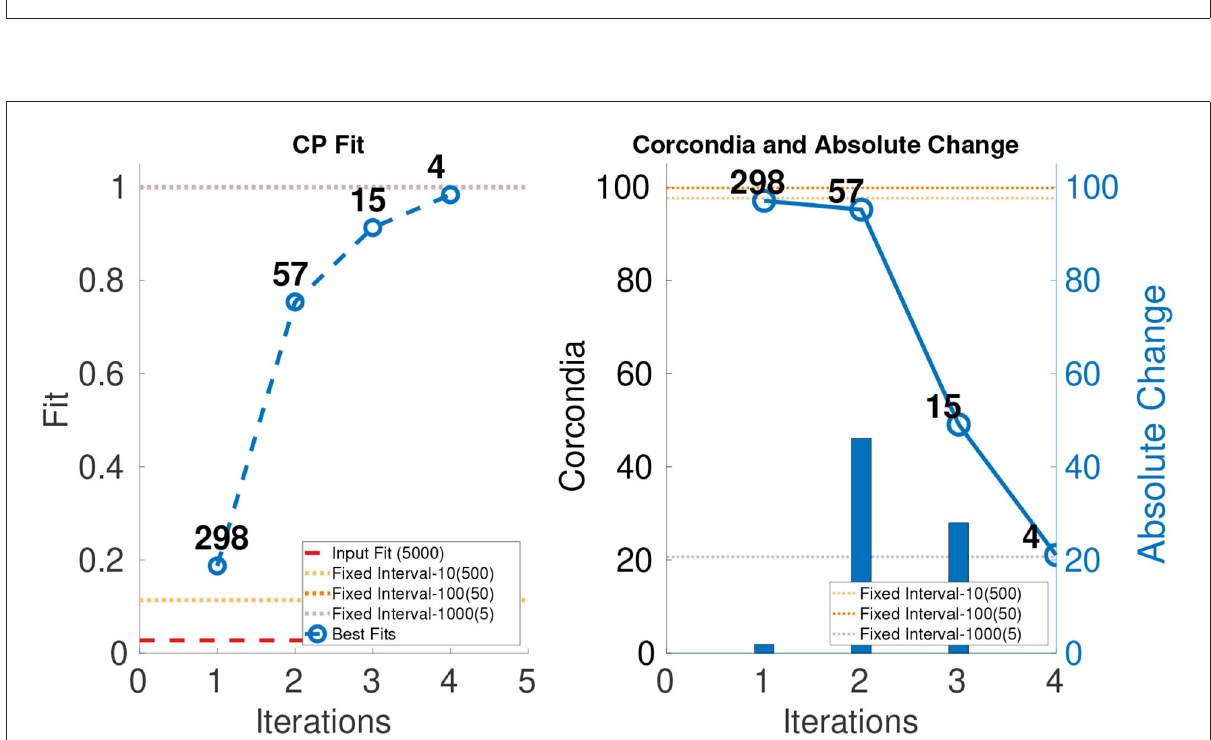
FIGURE4 CP fit and CORCONDIA of best fit tensor and its absolute change at each iteration for